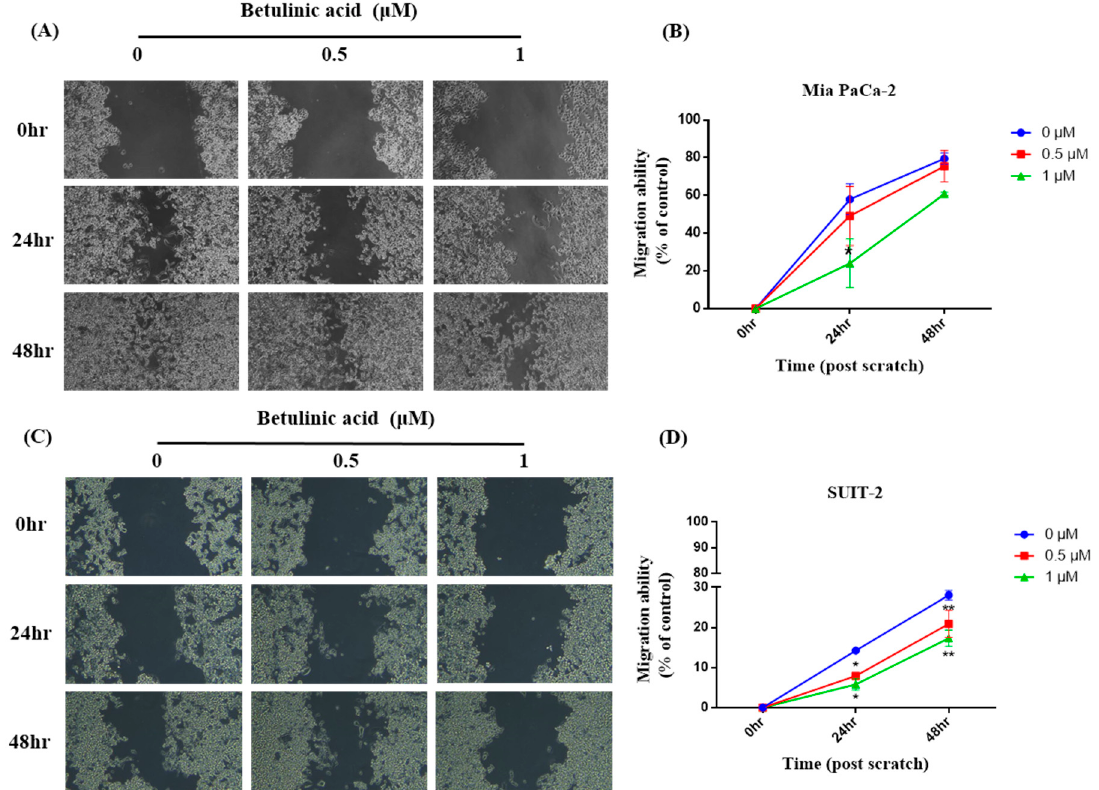
Figure 1. Effects of betulinic acid (BA) on Mia PaCa-2 and SUIT-2 cell migration. ( A , C ) Cells were treated with BA for up to 48 h at concentrations of 0, 0.5, and 1 μ M. The cell migratory ability was evaluated by a wound-healing assay, and representative images were captured under a phase-contrast microscope at 20× magnification. ( B , D ) Quantitative analysis of the migration of Mia PaCa-2 and SUIT-2 cells was calculated using ImageJ software. The migratory ability is expressed as a percentage of the wound-closure area compared to that of the control (0 h). Data are expressed as the mean ± SEM (n = 2). * p < 0.05 and ** p < 0.01 compared to the 0 μ M group at the same treatment period.